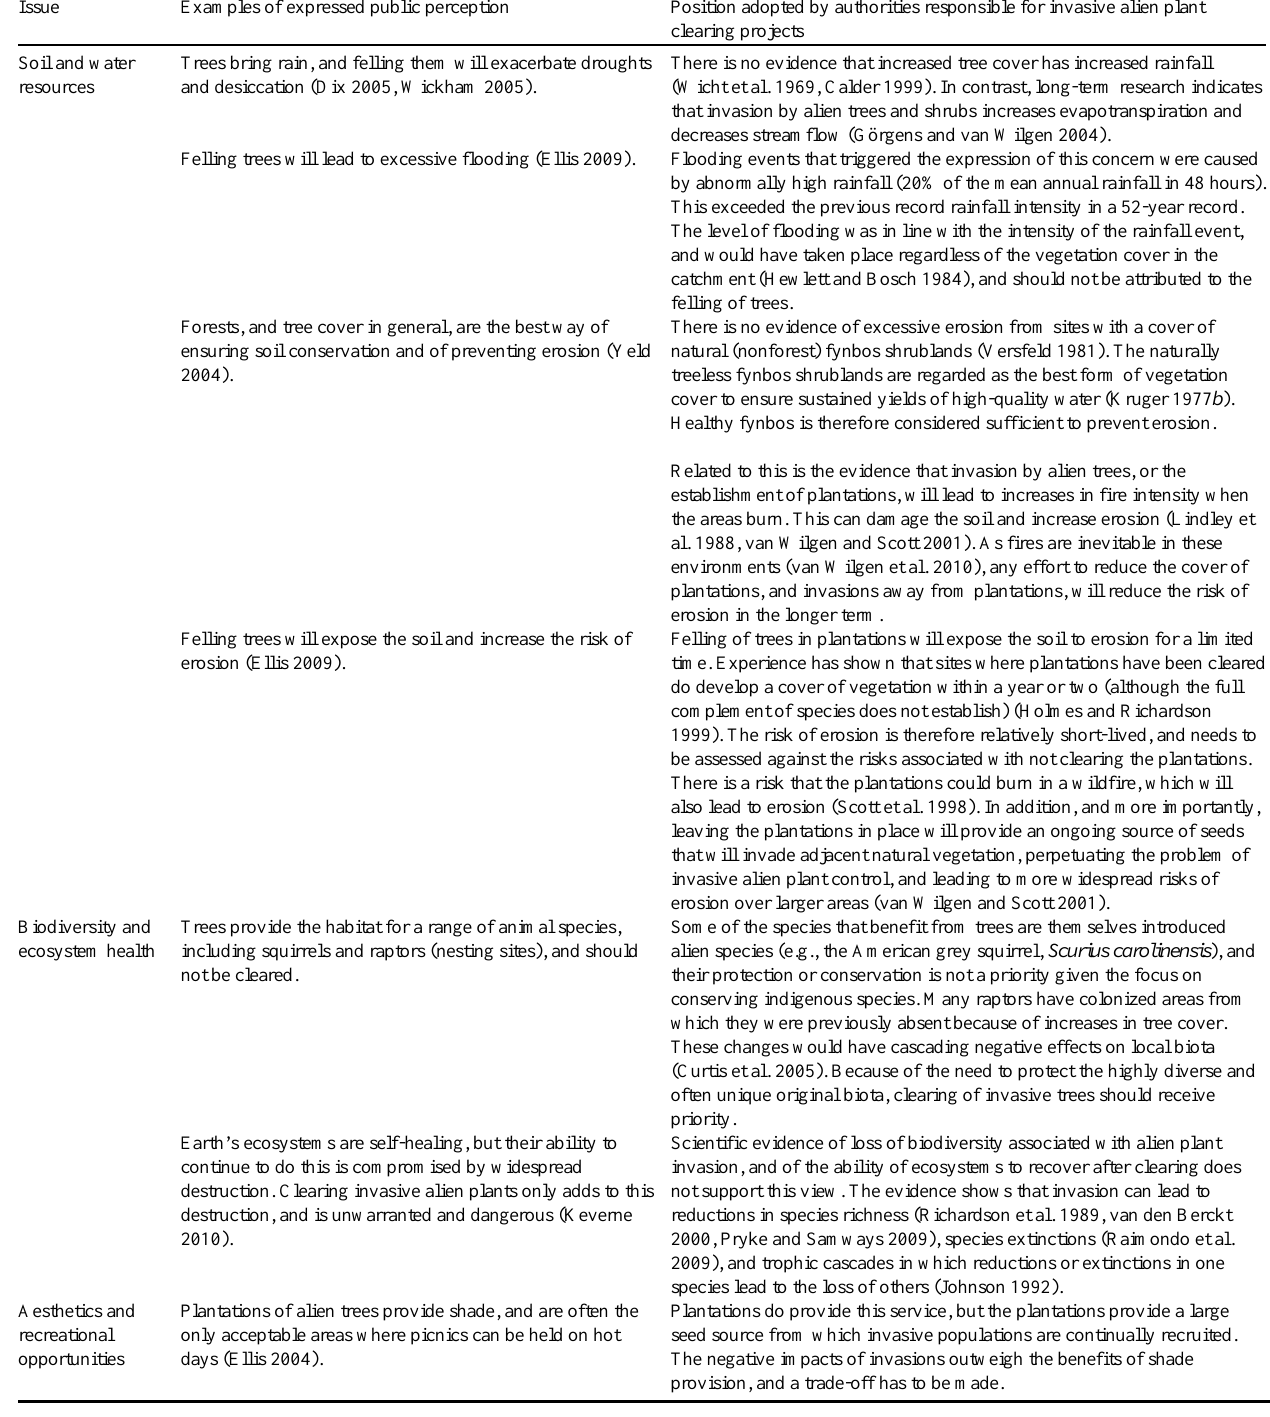
Table 1 . Major issues relating to the control of invasive alien plants, related perceptions expressed by citizens, and the position adopted by authorities responsible for invasive alien plant clearing projects in the Table Mountain National Park. Some examples of typical press articles are